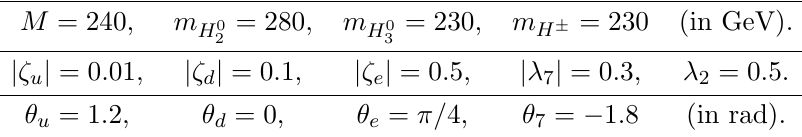
Table 3 . Input values for the THDM at the scale m Z